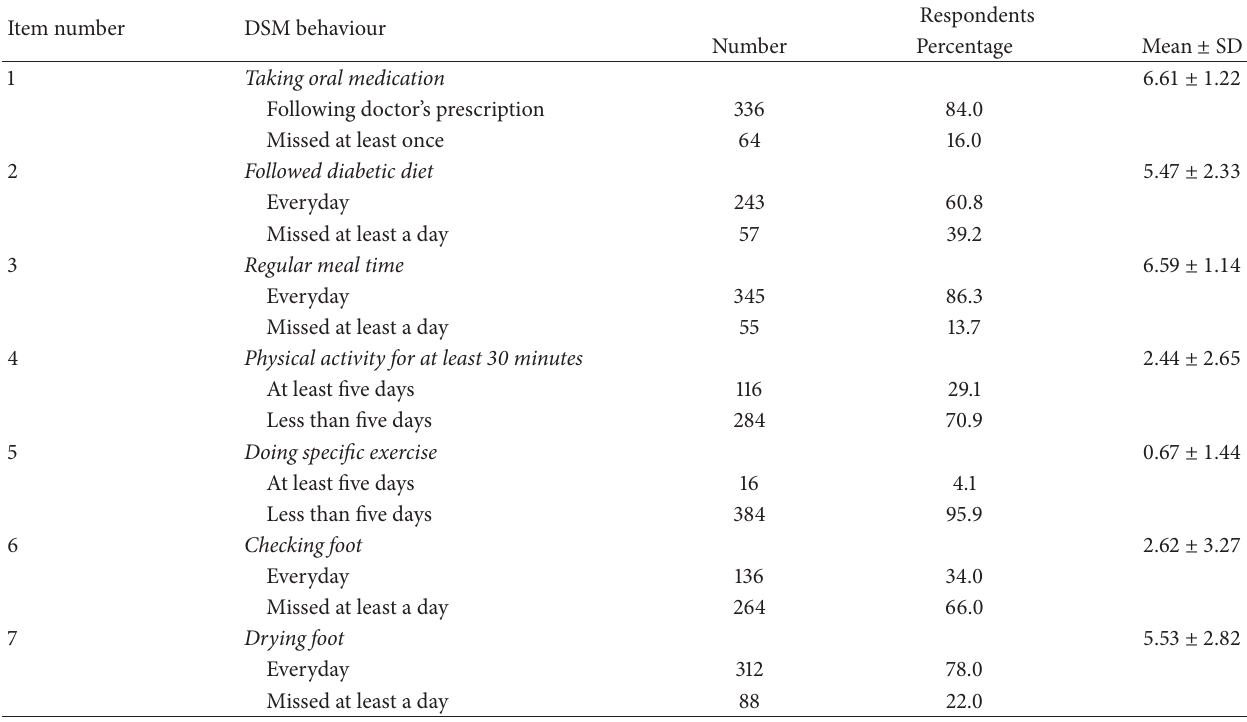
Table 3: DSM status of the respondents ( 𝑛 = 400 ).